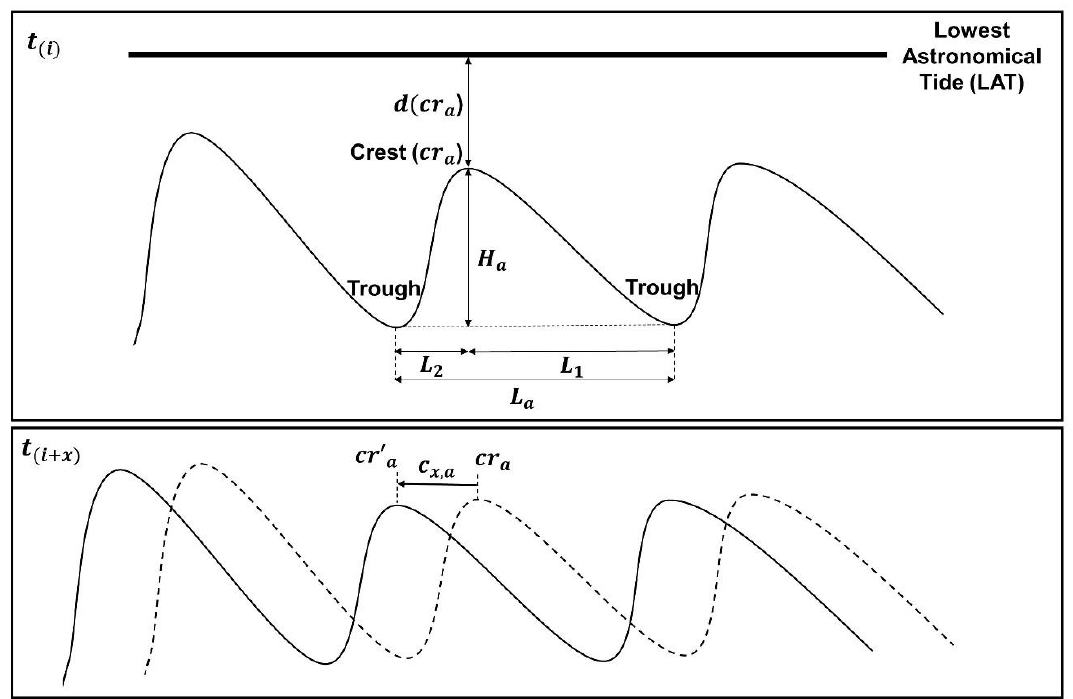
Figure 3. Illustration representing sediment wave (SW) characteristics used in this study. For SW “a”, the Figure denotes 𝑐𝑟 = SW crest; 𝑑(𝑐𝑟) = water depth of SW crest; H = SW height; L = SW wavelength (and length components 𝐿 1 and 𝐿 2 ); 𝑡 (𝑖) = time of first bathymetric survey over SW field; 𝑐 (𝑥) = displacement of SW crest over time interval 𝑥 ; 𝑐𝑟′ = position of displaced SW crest over time interval 𝑥 . Table 3. Sediment wave size classification scheme used in this study. Source: Van Landeghem, et al., [56] and Evans, et al., [79], originally adapted from Ashley [46] and Berne, et al., [80].